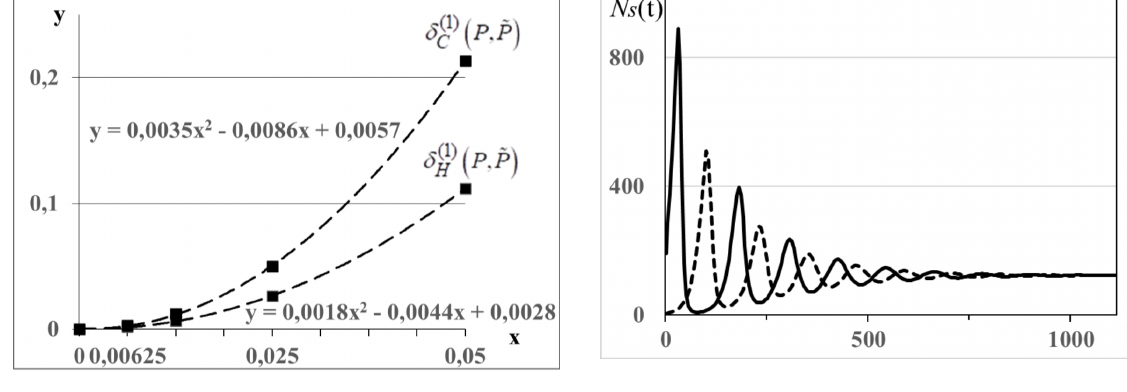
Fig. 6. Graphs of N S ( t ) for oscillating dynamics for 2 different initial values ϕ ( a ) .